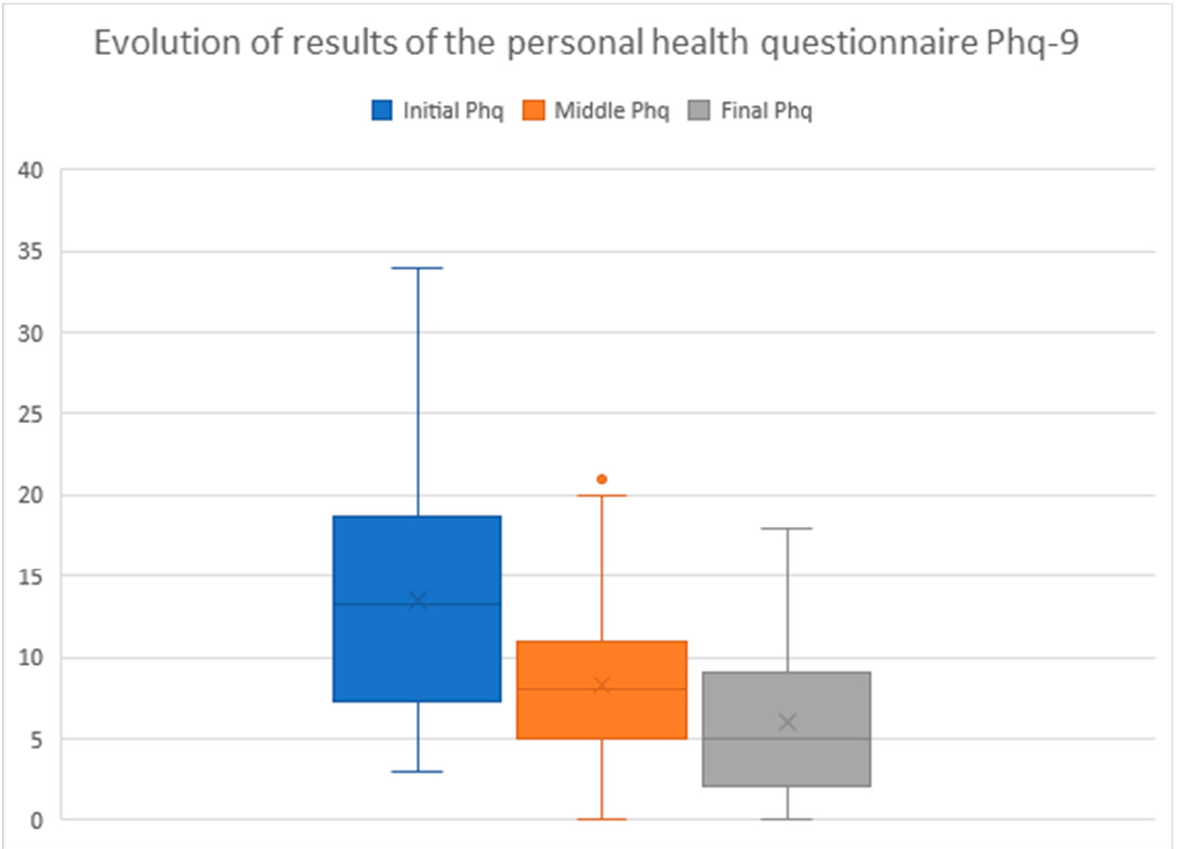
Figure 1. Data representation of the initial, middle, and final PHQ-9 ( n = 39).